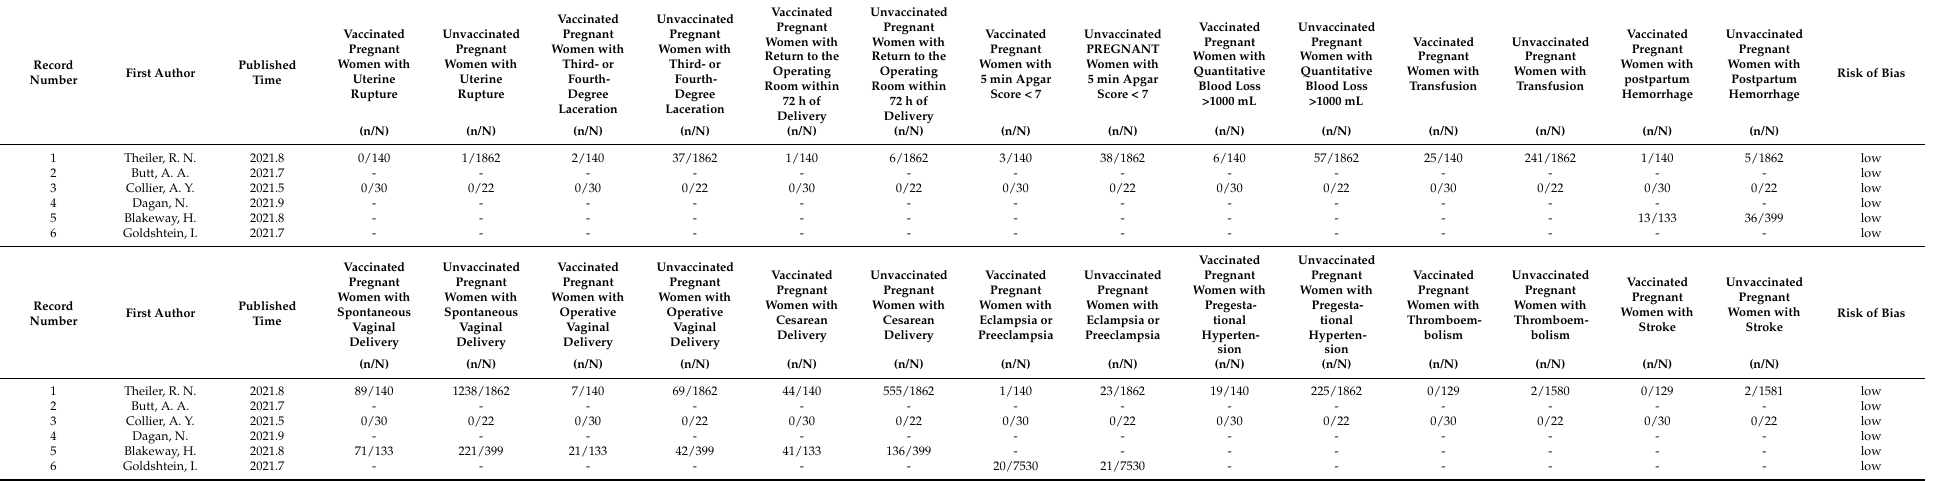
Table 2. Findings of included original studies for adverse pregnancy